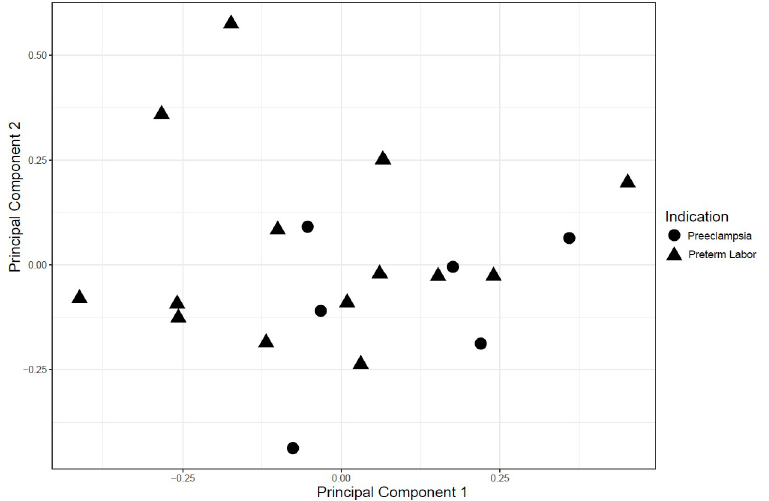
Fig 4. Plot of principal components 1 and 2 for miRNA expression in FFPE umbilical cord tissue of controls. Shapes indicate primary reason for preterm delivery.